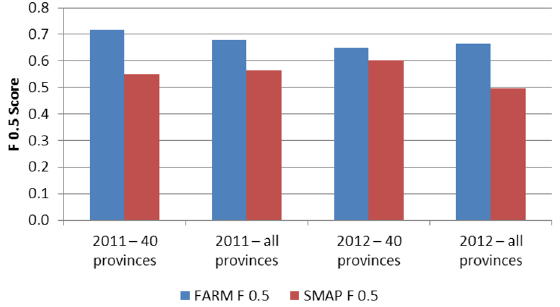
Figure 8. Comparison of F0.5 using four data sets for simple autoregression (SP) and the FARM method used in this